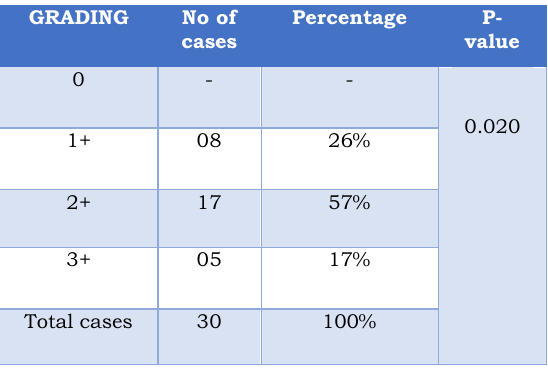
Table 2: Distribution of cases according to grading of interstitial cells of Cajal (ICCS) using CD117